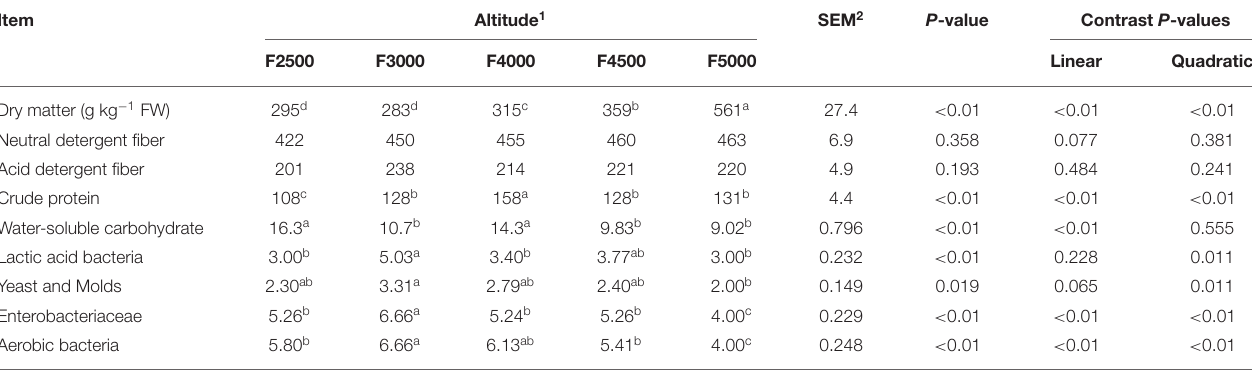
TABLE 1 | The chemical composition (g kg − 1 DM basis unless stated otherwise) and microbial populations (log 10 CFU g − 1 FW) of fresh K. pygmaea along the elevation gradient on the Tibetan Plateau.